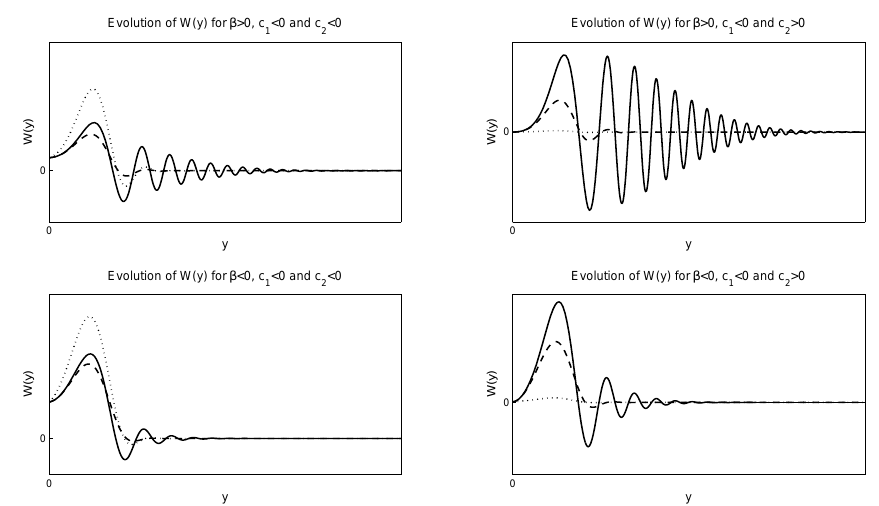
Figure 1. Evolution of the solution Equation (50) of the Heston model. For the numerical solutions, we select ρ = 0.5, β = | 0.7 | , r = 0.5, κ 1 = 1 and κ 2 = 0.5. The left figures are for negative c 1 , c 2 , while the right figures are for negative c 1 and positive c 2 . The solid lines are for | c 2 | = 5 | c 1 | , the dotted lines are for | c 2 | = 0.2 | c 1 | , and the dash-dash lines are for | c 2 | = | c 1 | . The top figures are for β > 0, while the lower figures for β < 0.